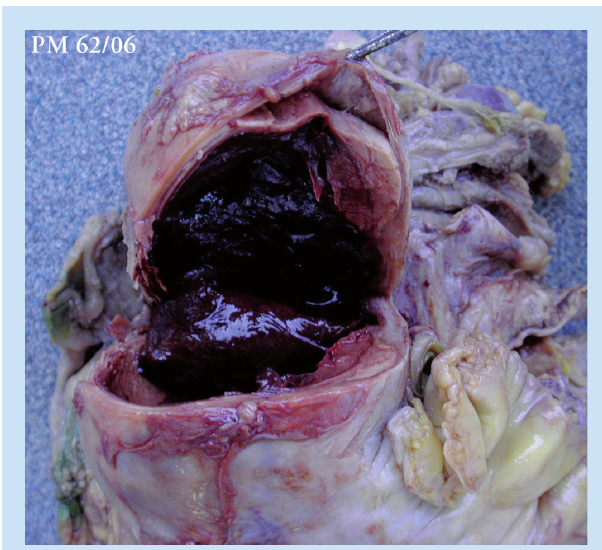
Fig. 5. Superior mesenteric artery aneurysm with post-mortem ‘red- currant jelly’ blood clot. Minimal antemortem thrombus present.